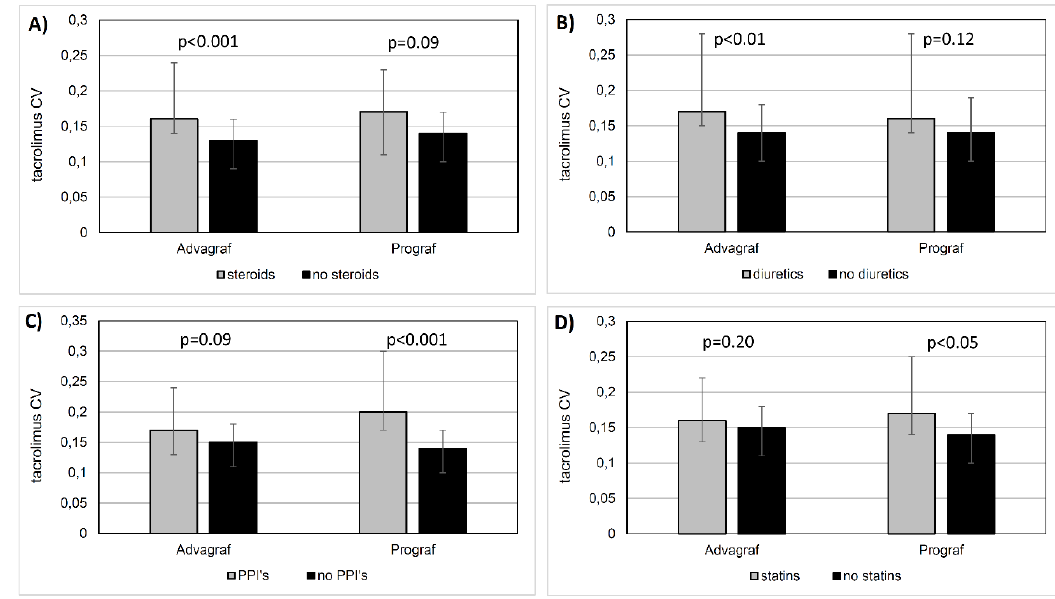
Figure 3. The comparison of tacrolimus coefficient of variation (CV) values in patients treated with once-daily or twice-daily tacrolimus formulation as depends on different classes on concomitant medication: ( A ) steroids, ( B ) diuretics, ( C ) proton pump inhibitors, and ( D ) statins.